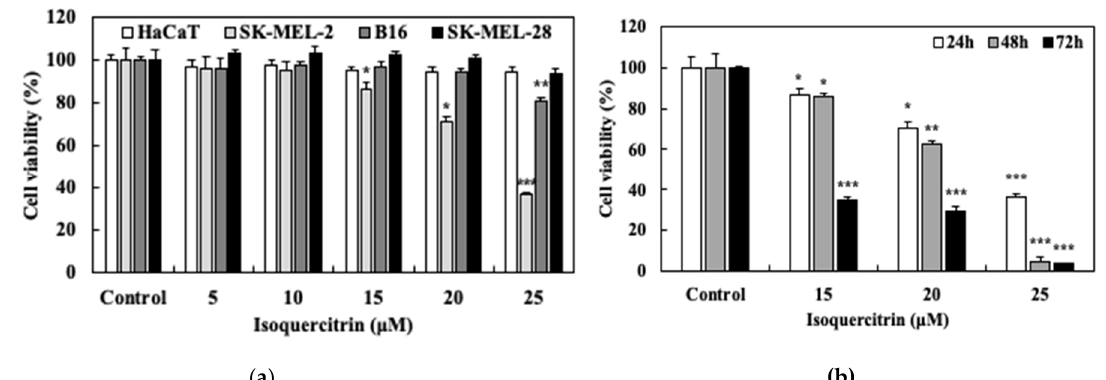
Figure 2. E ff ect of isoquercitrin on the viability of melanoma cells. ( a ) HaCaT normal skin cells, SK-MEL-2 and SK-MEL-28 human skin cancer cells, and B16 murine melanoma cells were treated with 5, 10, 15, 20, and 25 µ M of isoquercitrin for 24 h. SRB assay was performed to measure the cell viability. ( b ) SK-MEL-2 melanoma cells were treated with 15, 20, and 25 µ M of isoquercitrin for 24, 48, and 72 h. SRB assay was performed to evaluate the cell viability. Results are expressed as a percentage. Data